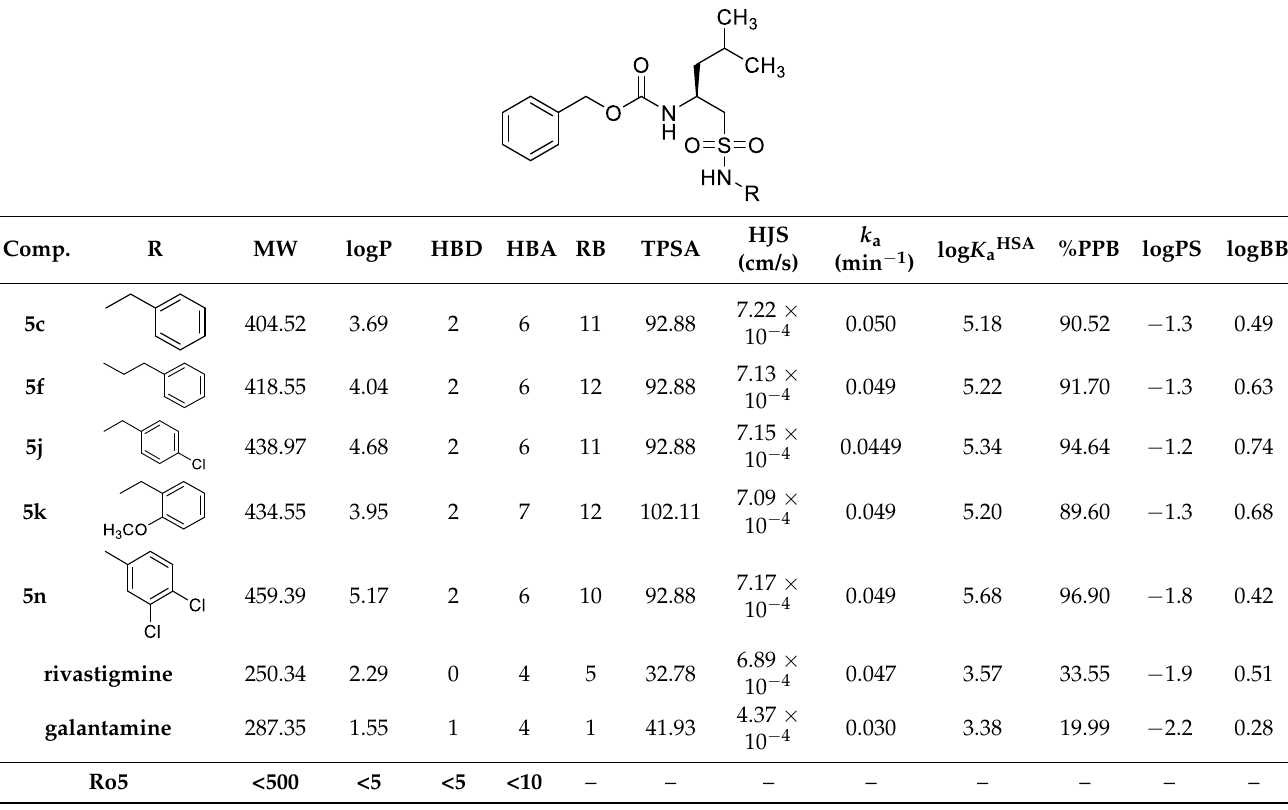
Table 2. Values of parameters predicted using ACD/Percepta ver. 2012 and characterizing the properties of selected most pronounced BChE inhibitors in comparison with rivastigmine and galantamine in relation to Lipinski’s Rule of Five (Ro5) and some other selected criteria.